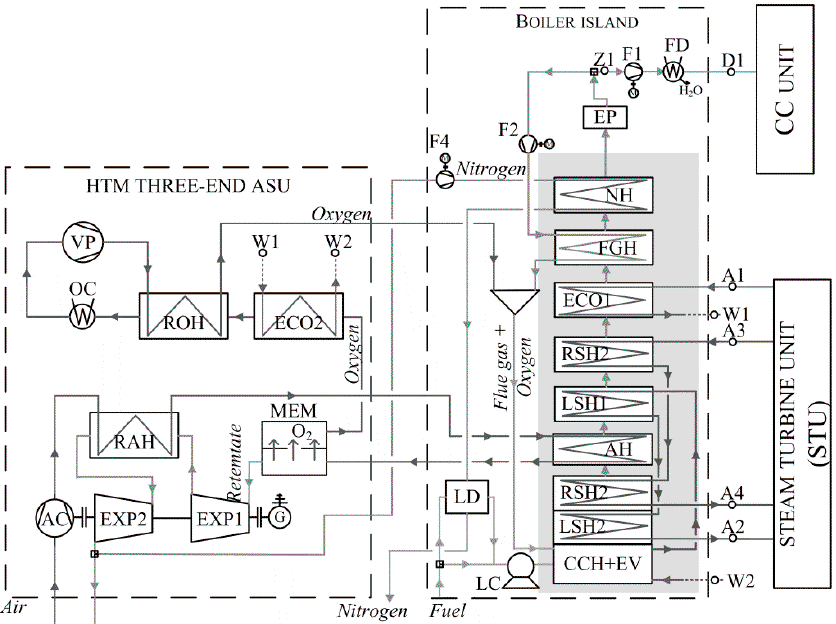
Figure 6. Scheme of a fluidized-bed boiler integrated with an ASU equipped with a three-end type